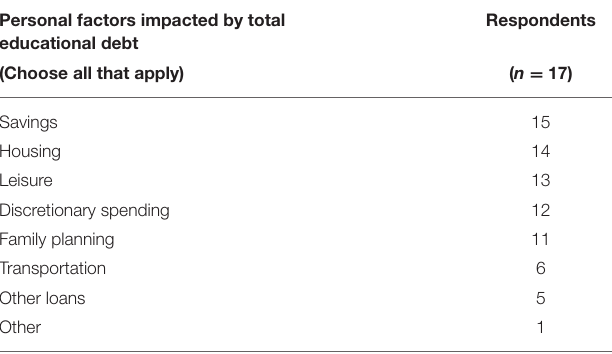
TABLE 3 | Personal factors impacted by total educational debt.